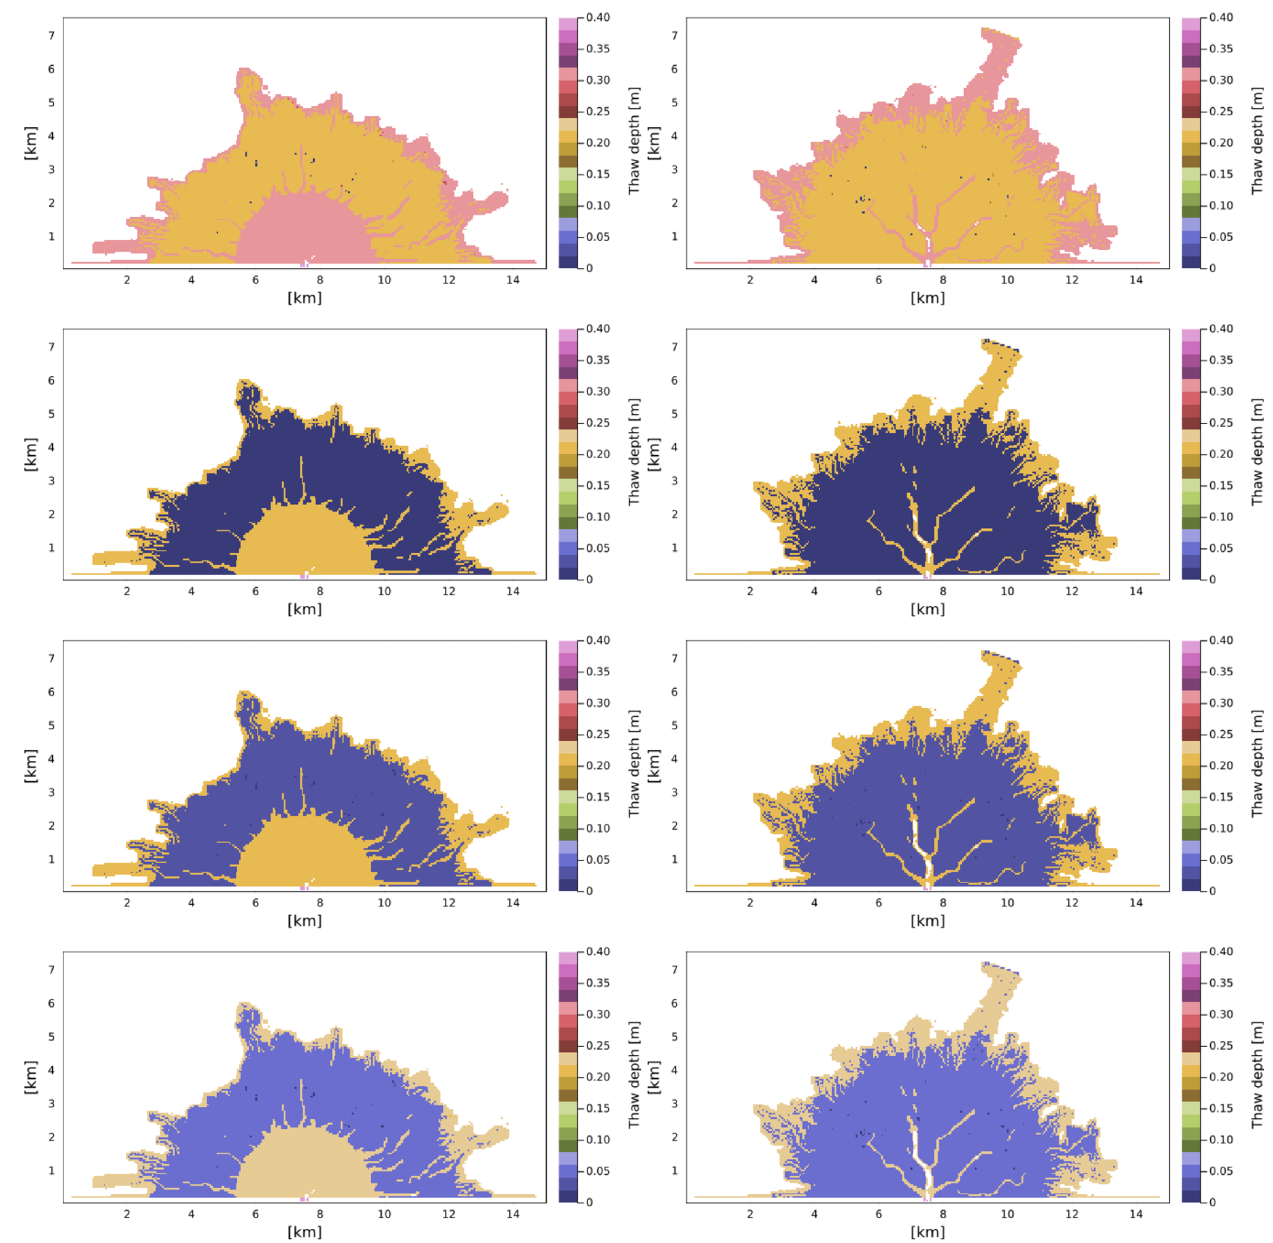
Figure C1. Evolution of thaw depths in the time steps around the final ice-cover maximum in the simulations in (left column panels) Fig. 4b and (right column panels) Fig. 4f. The time steps shown here are, from top to bottom, step number 4970 to 4973 out of 5000 (not counting the 300-step ramp-up phase). These correspond to the time step before the last winter ice maximum of the simulation through to two steps afterwards. Thaw depths are defined only where there are at least one vertical grid cell of sediments accumulated. Note that these plots show only the thaw depths from the top of any accumulated sediment column, and do not reflect elevation information. The contrast between the left and right columns, corresponding respectively to ice extents of 40% and 100%, shows that the thaw depths are directly influenced by the winter ice cover in our model. These thaw-depth patterns provide a visual sense of how the interplay and balances of processes in ArcDelRCM.jl, as discussed in Sect. 4, are spatially